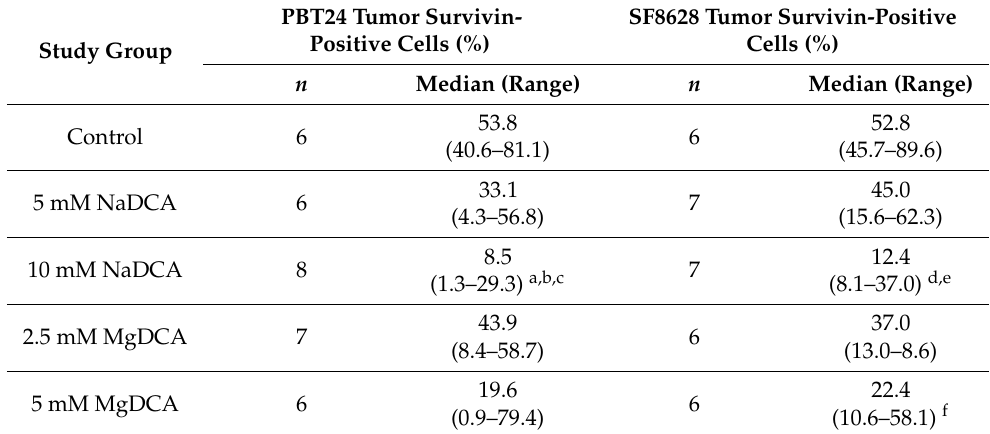
Table 5. The percentage of survivin-positive cells in PBT24 and SF8628 tumors groups. PBT24 Tumor Survivin- Study Group